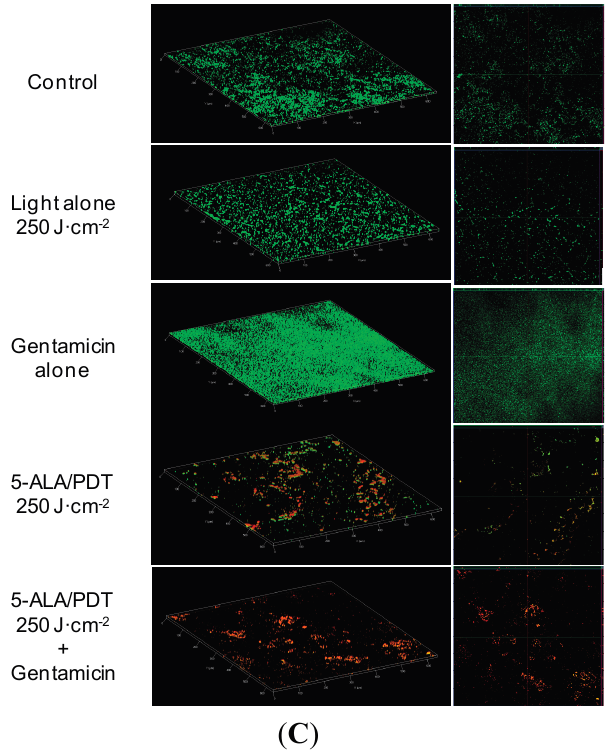
Figure 3. ( A ) Confocal laser scanner microscopy (CLSM) micrographs: three dimensional ( left panels ) and orthogonal reconstructions ( right panels ) of the biofilm formed by S. aureus . The pictures refer to the various experimental conditions as indicated on the left. Light fluence was set at 250 J·cm − 2 , Gentamicin concentration at 2 μ g/mL. The fluorescence is associated with live (green) and dead (red) cells, respectively; ( B ) CLSM micrographs: three dimensional ( left panel ) and orthogonal reconstructions ( right panel ) of the biofilm formed by S. epidermidis . The pictures refer to the various experimental conditions as indicated on the left. Light fluence was set at 250 J·cm − 2 , Gentamicin concentration at 2 μ g/mL. The fluorescence is associated with live (green) and dead (red) cells, respectively; ( C ) CLSM micrographs: three dimensional ( left panels ) and orthogonal reconstructions ( right panels ) of biofilm formed by S. haemolyticus . The pictures refer to the various experimental conditions as indicated on the left. Light fluence was set at 250 J·cm − 2 , Gentamicin concentration at 2 μ g/mL. The fluorescence is associated with live (green) and dead (red) cells, respectively. Scale bars represent 100 μ m as indicated in